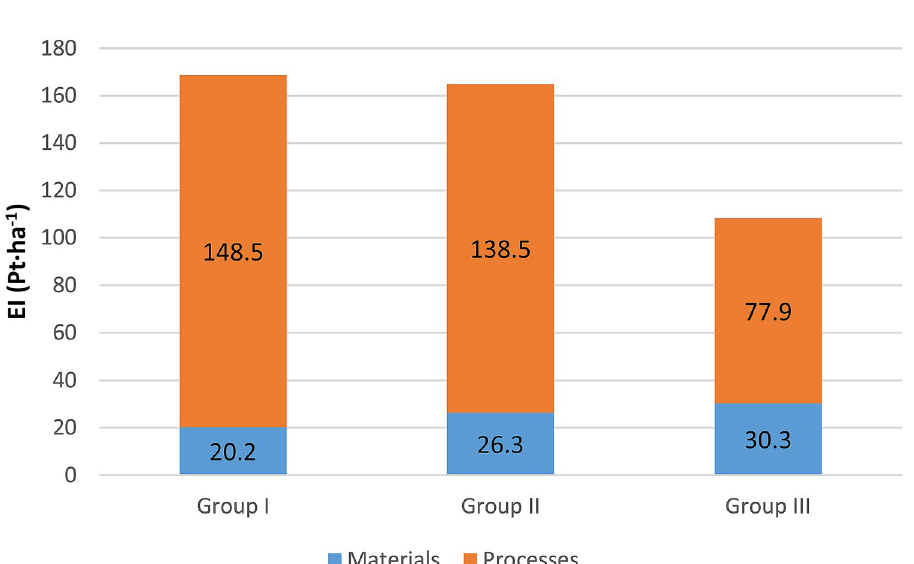
Figure 4. The structure of the total environmental impact as per plantation area.